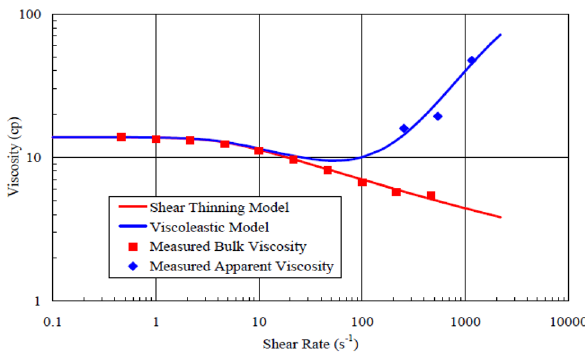
Fig. 10 Viscosity versus shear rate for 1500 ppm Flopaam 3630S (from Delshad et al.